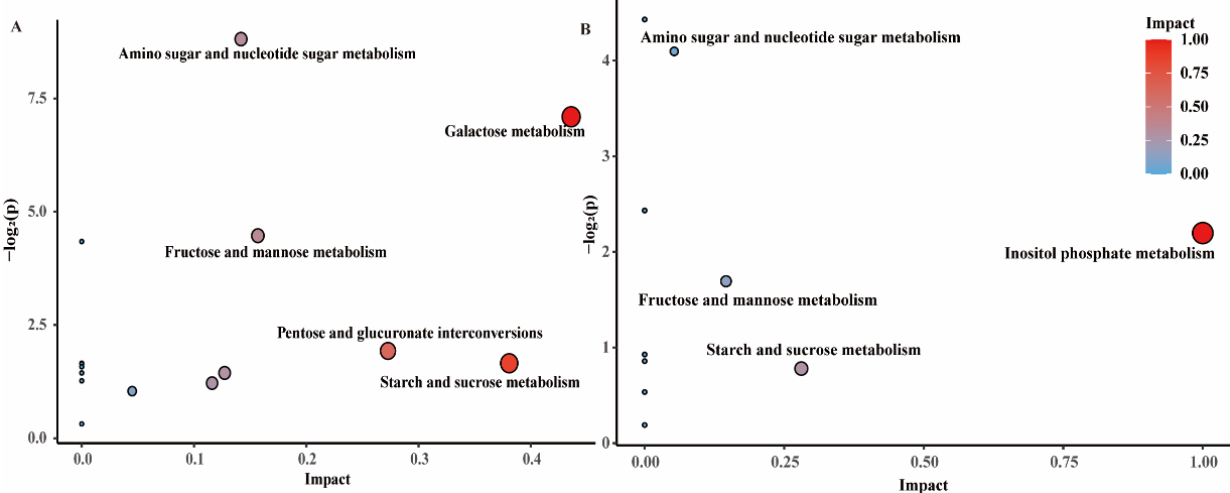
Figure 3. Pathway enrichment analysis (PEA) and pathway topology analysis (PTA) results. ( A ) Pathway enriched in C. albicans . ( B ) Pathway enriched in S. mutans .